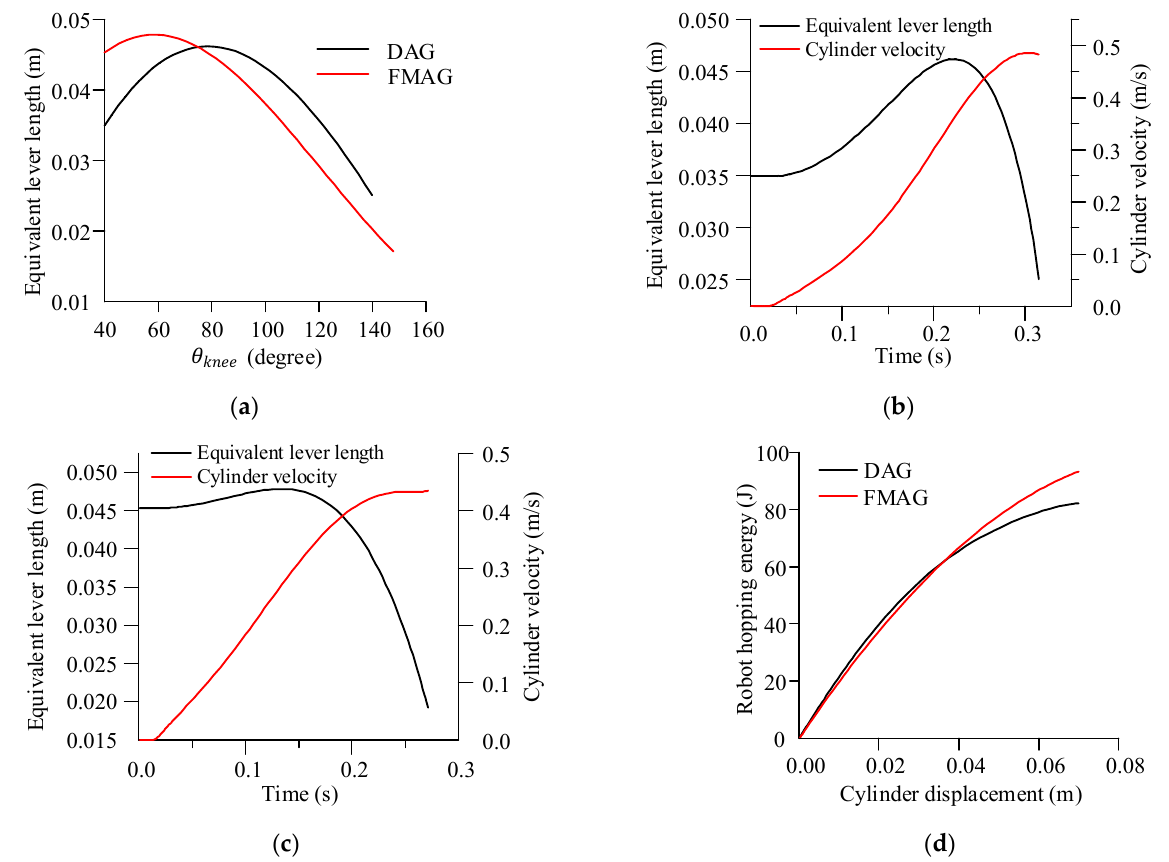
Figure 8. Analysis of the experiment results. ( a ) Relationship between the knee joint angle and the equivalent lever length; ( b ) Cylinder velocity and the corresponding equivalent lever length under the DAG; ( c ) Cylinder velocity and the corresponding equivalent lever length under the FMAG; ( d ) Robot hopping energy under the DAG and FMAG.